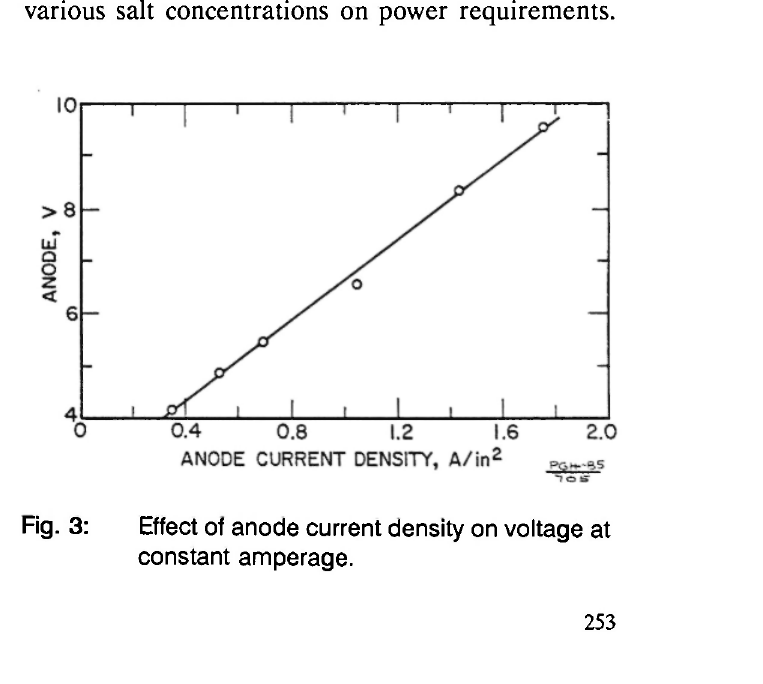
Effect of anode current density on voltage at constant